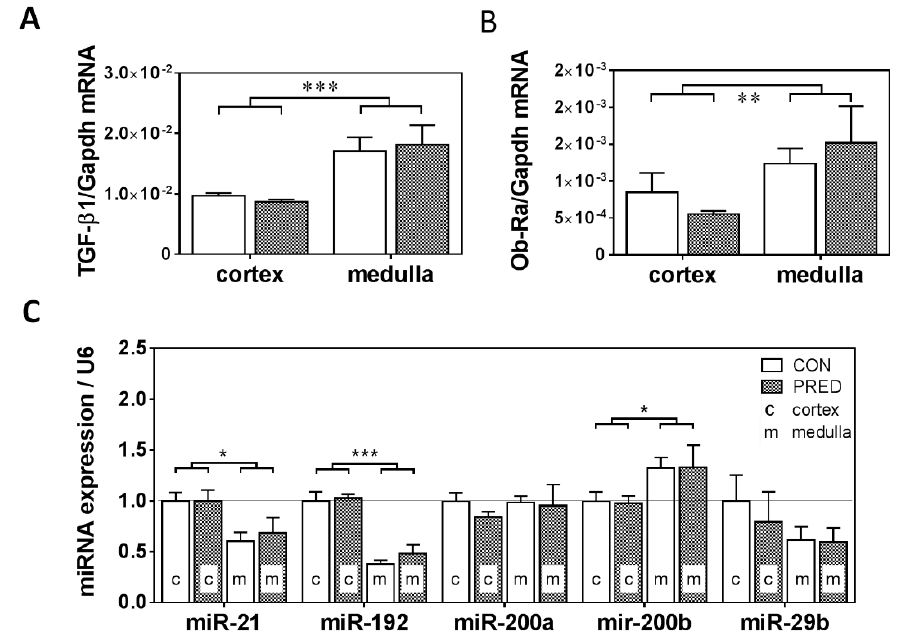
Figure 6. mRNA and miRNA markers of fibrosis in the kidney. ( A ) TGF- β 1 mRNA, ( B ) short-form of leptin-receptor ( Ob-Ra ) mRNA expression and ( C ) expression of renal fibrosis marker microRNAs (miR-21, miR-192, miR-200a, miR-200b, and miR-29b) in the kidney cortex (c) and medulla (m) in obese prediabetic (PRED, gray columns) and control (CON, white columns) rats at the end of the study. Data are means ± SEM, two-way RM ANOVA, n = 8-9 / group ( A –C); n ≥ 4 / group, expression of miRNAs is presented relative to their cortical expression in CON ( C ). *: p < 0.05, **: p < 0.01; ***: p < 0.0001.